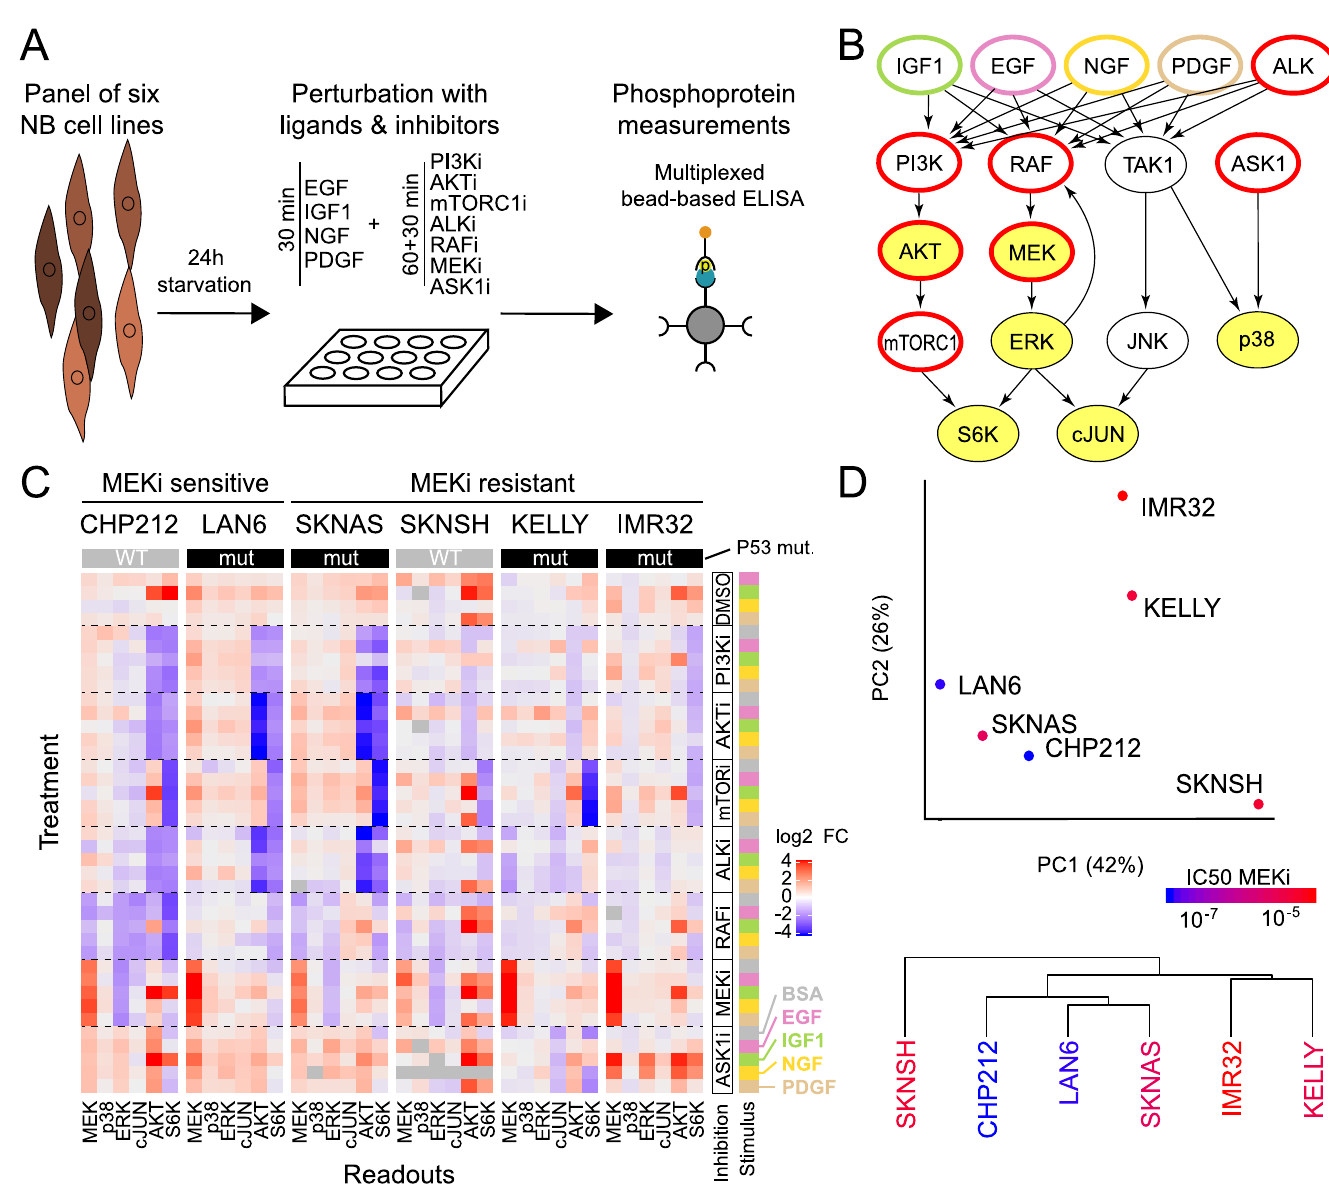
Fig 2. Neuroblastoma cell lines show heterogeneous responses to signalling perturbations. A: Outline of the perturbation experiments. A panel of cell lines was treated with growth factors and small molecule inhibitors, and the resulting effect on selected phosphoproteins was measured using multiplexed bead-based ELISAs. B: Graphical representation of the perturbation scheme on a literature signalling network. Blue and red contour highlights ligand stimulation and kinase inhibition, respectively; yellow filling shows measured phosphoproteins. C: Perturbation data obtained from applying all combinations of 4 ligands or BSA control and 7 inhibitors or DMSO control to 6 neuroblastoma cell lines. Each measurement is normalised by the BSA+DMSO control of the corresponding cell line and represents at least 2 biological replicates. Readouts are phospho-proteins p-MEK1 S217/S221 , p-p38 T180/Y182 , p-ERK1 T202/Y204 , p-cJUN S63 , p-AKT S473 and p-S6K T389 . D: Global non- mechanistic analysis of the perturbation data presented in C: TOP first two components of a principal component analysis and BOTTOM hierarchical clustering. Colour scale corresponds to the IC50 for AZD6244 treatment (see also Fig 1C).